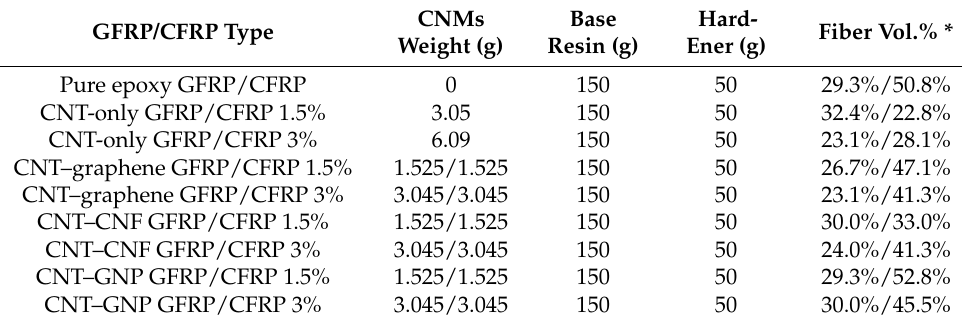
Table 4. Composite materials and their mix proportions.